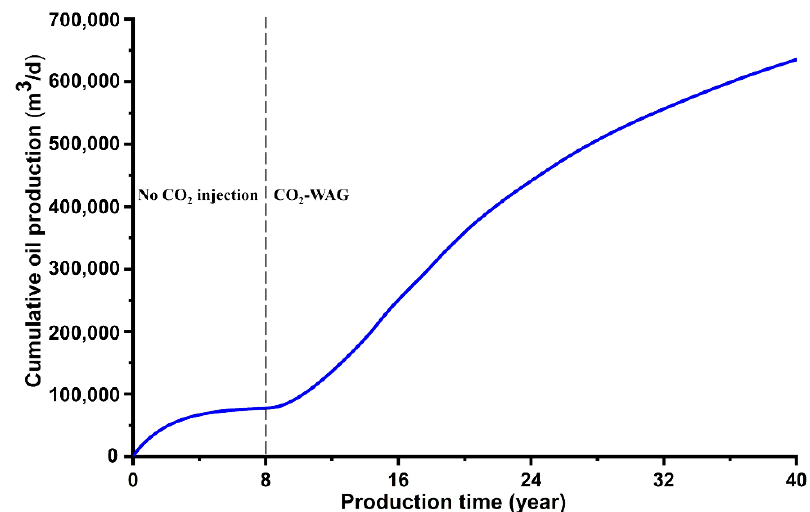
Figure 5. Cumulative oil production in the production process.